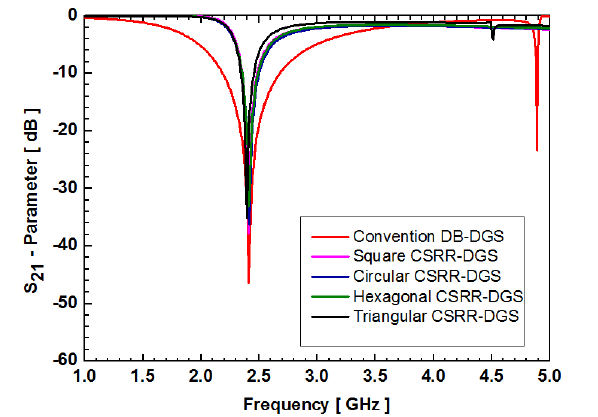
Fig. 2: Simulation results of microstrip bandstop filter with various CSRR-DGS